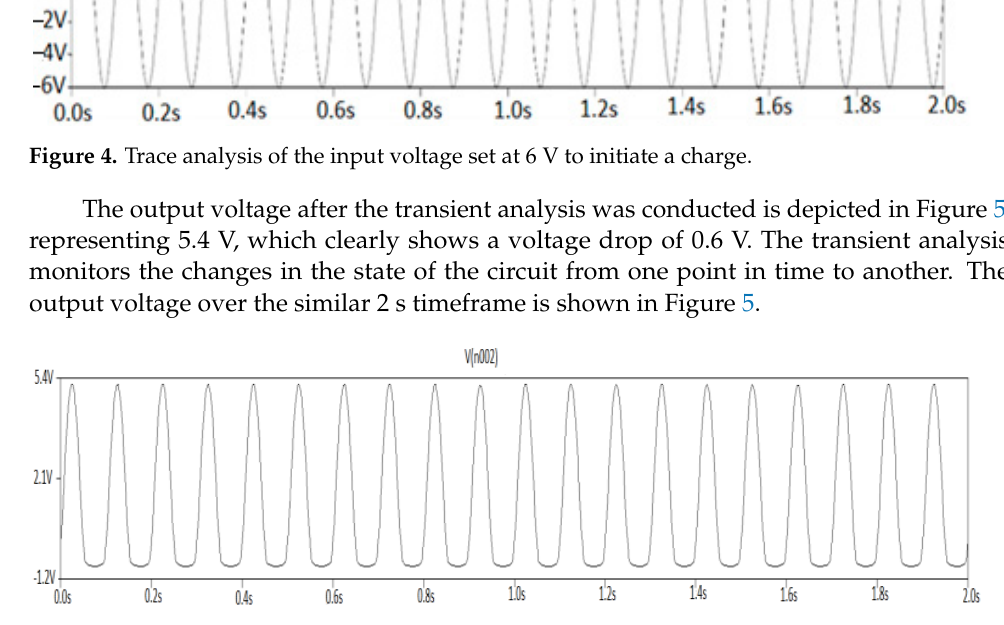
Figure 5. The predicted output voltage of the RF energy harvesting circuit. Table 1. Simulation Parameters